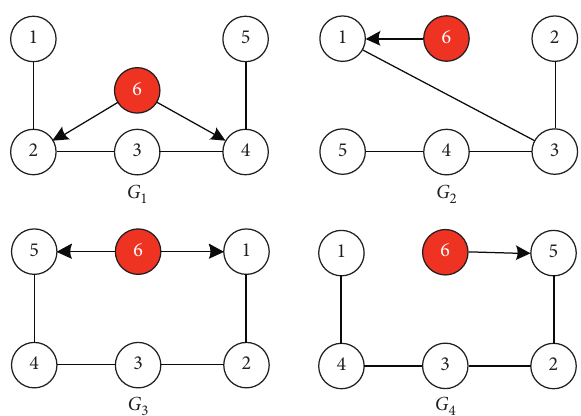
Figure 4: Leader-follower switching topologies.